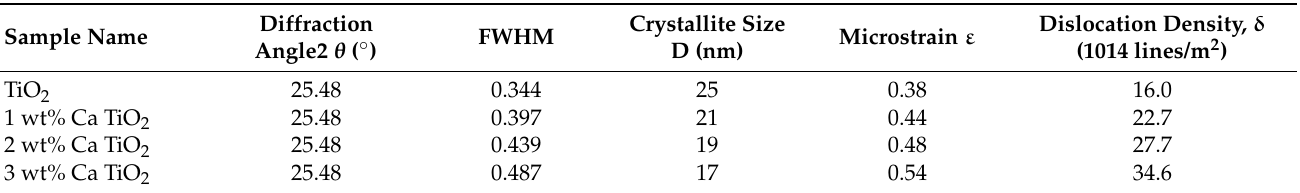
Table 1. Diffraction angle, full wave half maxima, crystallite size, microstrain, and dislocation